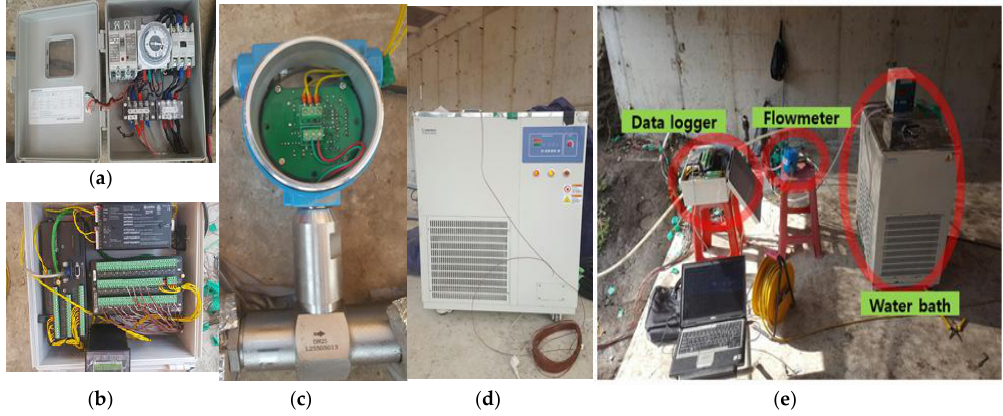
Figure 8. Experimental set-up and monitoring instruments of thermal performance tests (TPTs). ( a ) Time controller; ( b ) Data logger; ( c ) Flow meter; ( d ) Constant Temp water bath; ( e ) Experimental set-up.